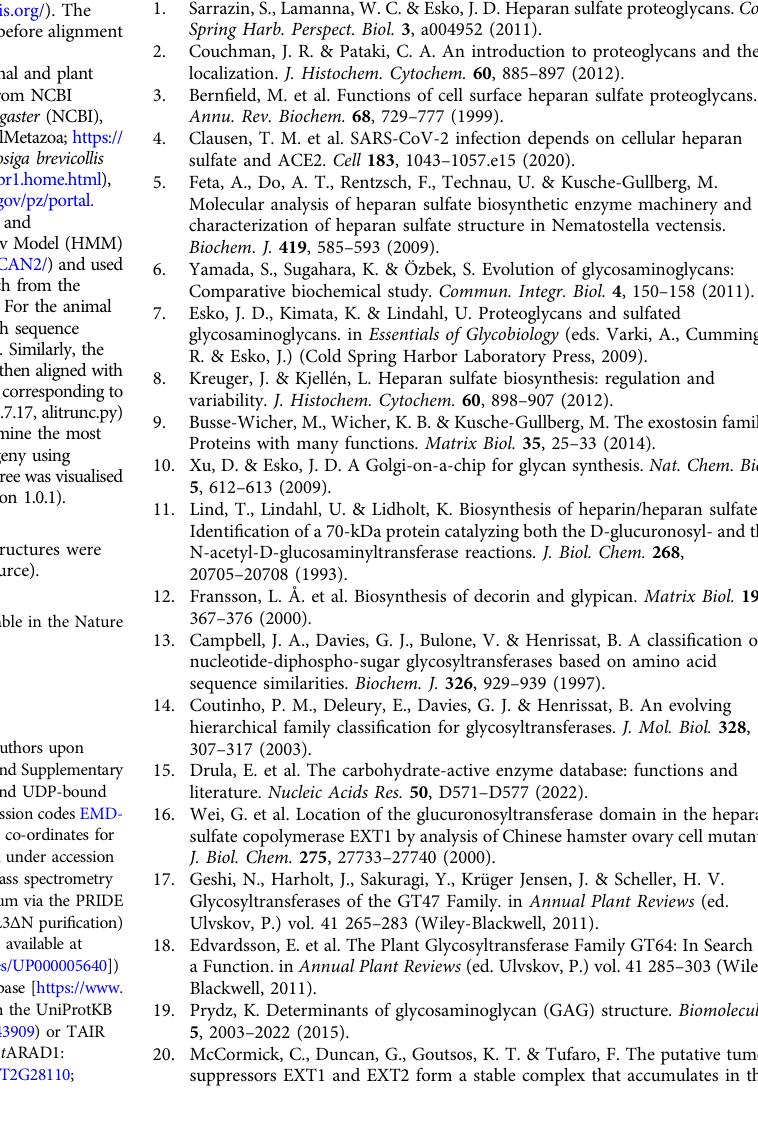
Figure preparation . All fi gures were prepared using Inkscape. Structures were rendered using ChimeraX and PyMOL (version 2.4.0a0 Open-Source). Reporting summary . Further information on research design is available in the Nature Research Reporting Summary linked to this